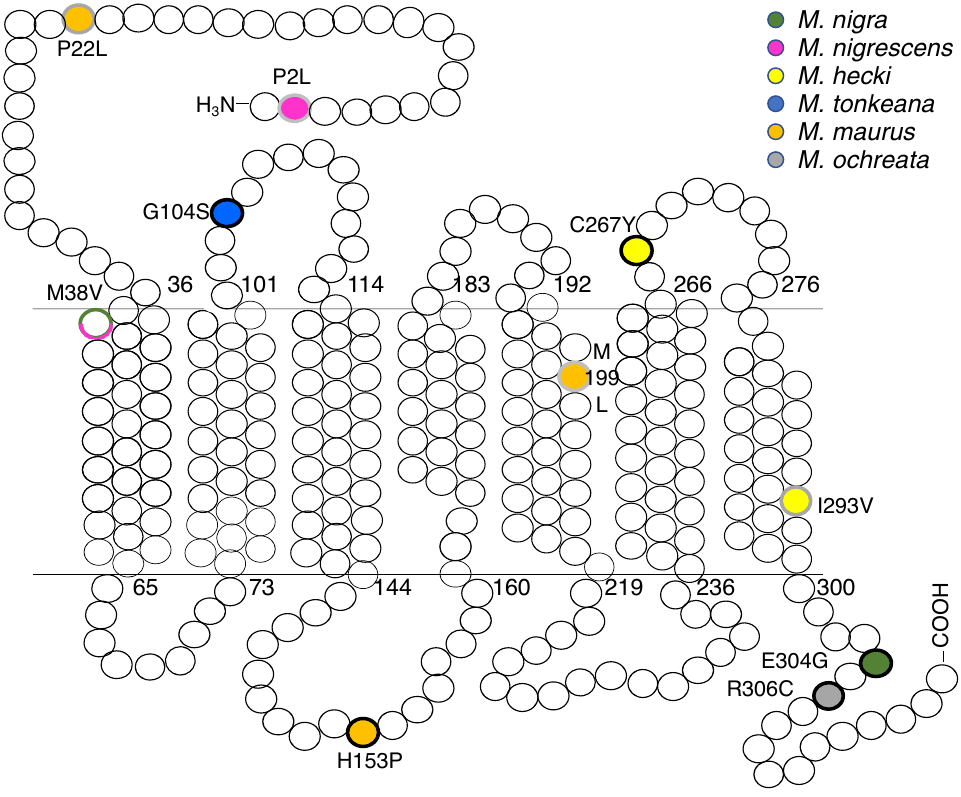
Figure 3. Schematic transmembrane topology for MC1R of Sulawesi macaques. Ten non-synonymous substitutions are shown. Each color represents a different species. The substitutions outlined in black are deleterious, as predicted by both SIFT and PROVEAN